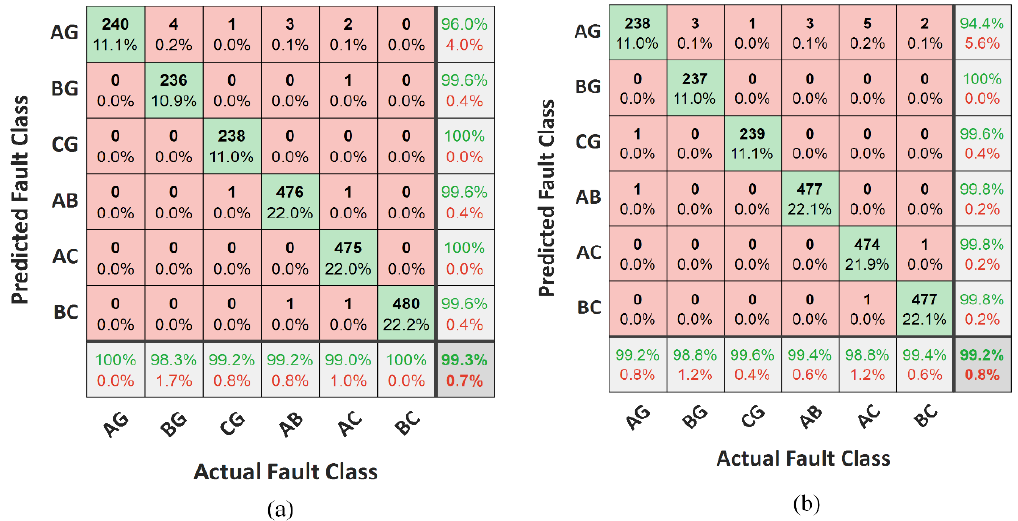
Figure 11. Confusion matrices of the testing dataset for fault classification unit during: ( a ) grid-tied mode; ( b ) islanded mode.